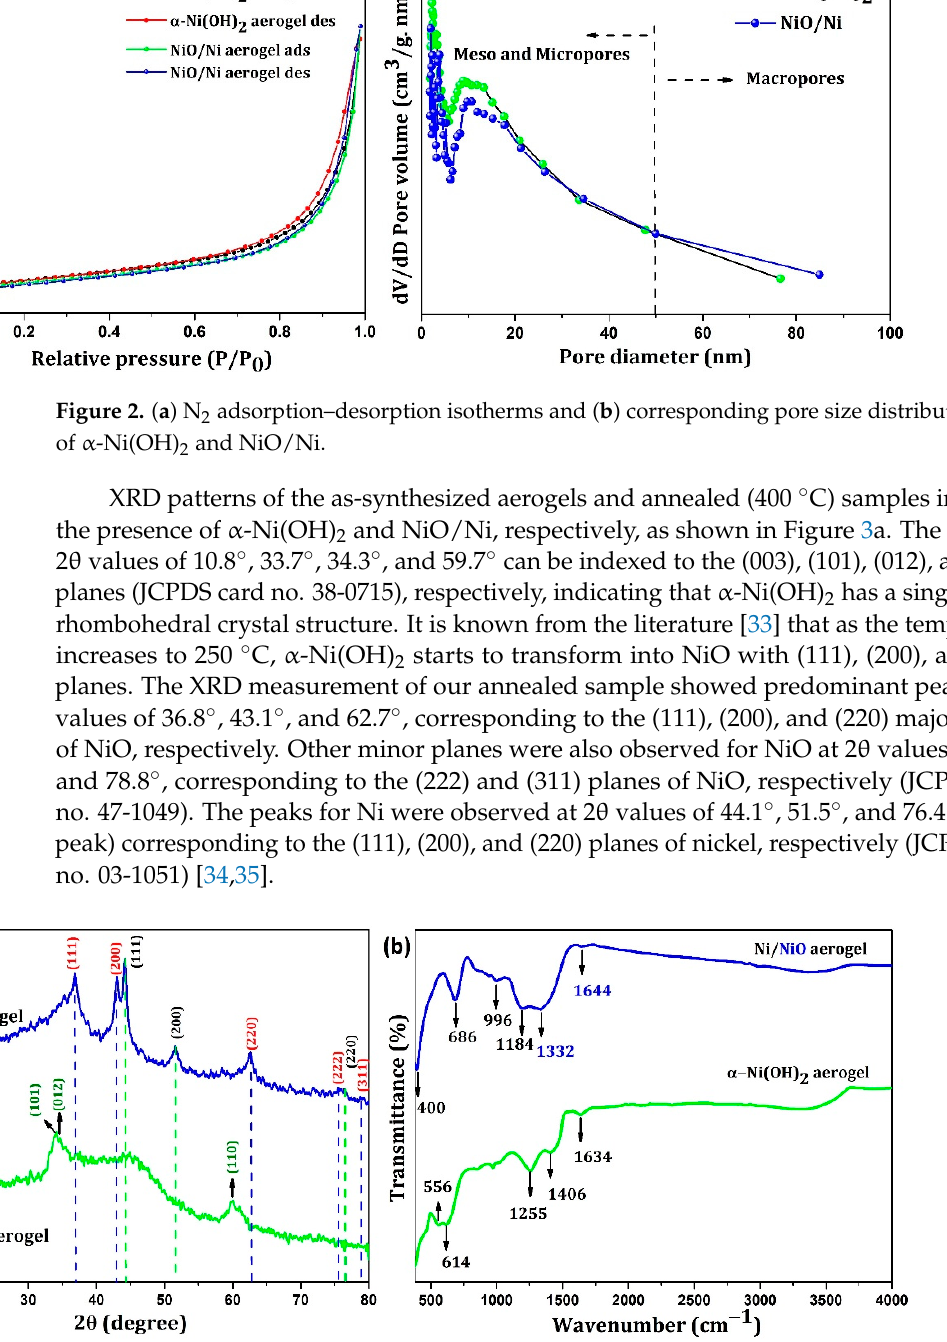
Figure 3. ( a ) XRD patterns and ( b ) FTIR spectra of the α -Ni(OH) 2 and NiO/Ni aerogels. The FTIR spectra of the α -Ni(OH) 2 and NiO/Ni aerogel samples are shown in Figure 3b. The spectrum highlighted in green shows typical characteristics of α -Ni(OH) 2 . The FTIR spectrum of the α -Ni(OH) 2 aerogel shows a broad band at approximately 3200–3700 cm − 1 , indicating the stretching vibrations of hydroxyl groups having hydrogen bonding with H 2 O, and the peak at 1634 cm − 1 can be assigned to the water bending mode. For the annealed samples, i.e., NiO/Ni aerogels, the peaks were observed at 3250–3700 cm − 1 in the form of a broad peak indicating the stretching vibrations of the hydroxyl groups’ stretch- ing region; the other peaks were observed at 1644, 1332, 1184, 996, 686, and 400 cm − 1 . The peaks at 996 and 686 cm − 1 correspond to the distinctive modes of the Bunsenite NiO phase [35]. XPS spectra were obtained to determine the chemical composition and valence state of each element in the as-synthesized and annealed aerogels. Figure 4 shows the XPS pro- files of α -Ni(OH) 2 and NiO/Ni. Both XPS spectra show high quantities of O and Ni, and trace amounts of C. The C 1 s peak at 284.4 eV may be due to the CO 2 absorbed into the aerogel samples exposed to air and adventitious hydrocarbons generated with the instru- ment itself [36]. A general observation is that due to its structural nature, α -Ni(OH) 2 is always in the hydrated form because water is intrinsic to its structure. For comparison purposes, the XPS of α -Ni(OH) 2 and NiO/Ni deconvoluted fitting is given in Figure S3 of the supplementary material. The deconvoluted spectra for Ni 2p 3/2 and Ni 2p 1/2 peaks are given in Figure 4c,d.